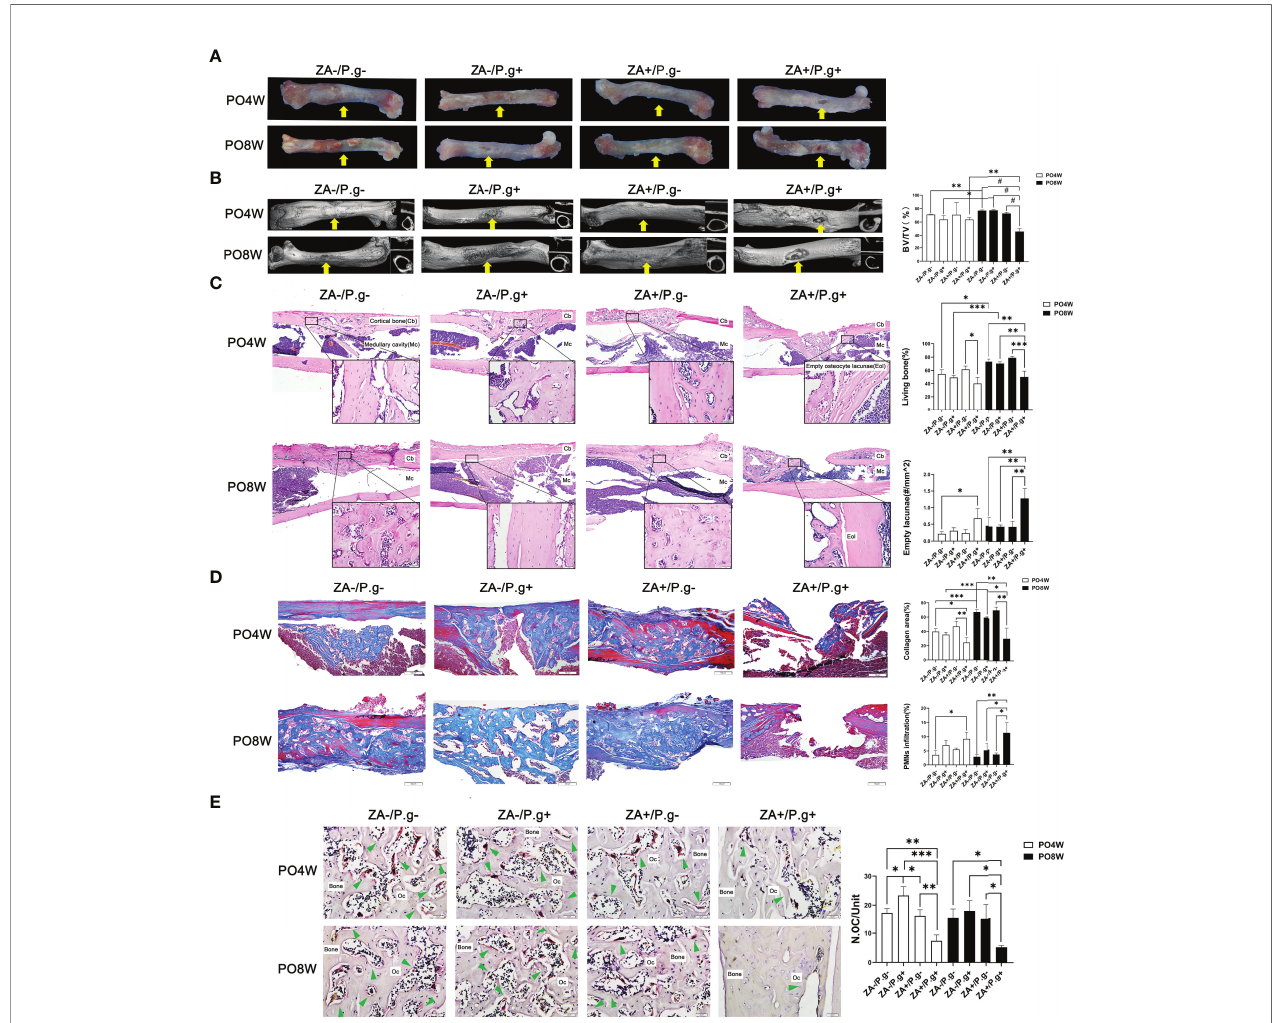
FIGURE 2 | ZA administration plus P. gingivalis infection suppressed soft and osseous tissue healing of femur defects. (A) Representative images of femur defects. At 4 or 8 weeks postoperatively, in the ZA-/ P.g -, ZA-/ P.g + and ZA+/ P.g - groups (F) the bone defects healed well and bone callus was present (yellow arrow); while incomplete healing of unilateral cortical bone (yellow arrow) was observed in the ZA+/ P.g + group (F). (B) Representative axial and sagittal Micro-CT slices and three- dimensional views of femur defect areas at week 4 and 8 postoperatively. At 4 weeks postoperatively, the femur defects of the ZA-/ P.g -, ZA-/ P.g + and ZA+/ P.g - groups (F) showed callus formation and bone regeneration, while the ZA+/ P.g + group (F) showed poor healing of unilateral cortical bone. At 8 weeks postoperatively, the femur defects of the ZA-/ P.g -, ZA-/ P.g + and ZA+/ P.g - groups (F) showed bone regeneration and complete full thickness bridging, while the ZA+/ P.g + group (F) showed rare bone regeneration and poor healing. Quantitative evaluation is also shown. BV/TV, bone volume/tissue volume. Yellow arrows indicate the femur defects. (C) Representative sagittal H-E-stained sections and quantitative evaluation of the histological parameters of femur defects (bar: 100 m m and 20 m m, 10× and 40× magni fi cation, respectively). There were unilateral incomplete healing and empty lacunae around the defect areas in the ZA+/ P.g + group (F). (D) Representative sagittal trichrome-stained sections and quantitative evaluation of the histological parameters of femur defects (bar: 100 m m, 10× magni fi cation). There were less collagen fi bers and more PMNs in the ZA+/ P.g + group (F) compared to the other groups. (E) Representative histological TRAP-stained section of femur defect areas (bar: 20 m m, 40× magni fi cation). Statistical analysis showed that in the ZA+/ P.g + group (F) the number of osteoclasts was signi fi cantly decreased. Cb, cortical